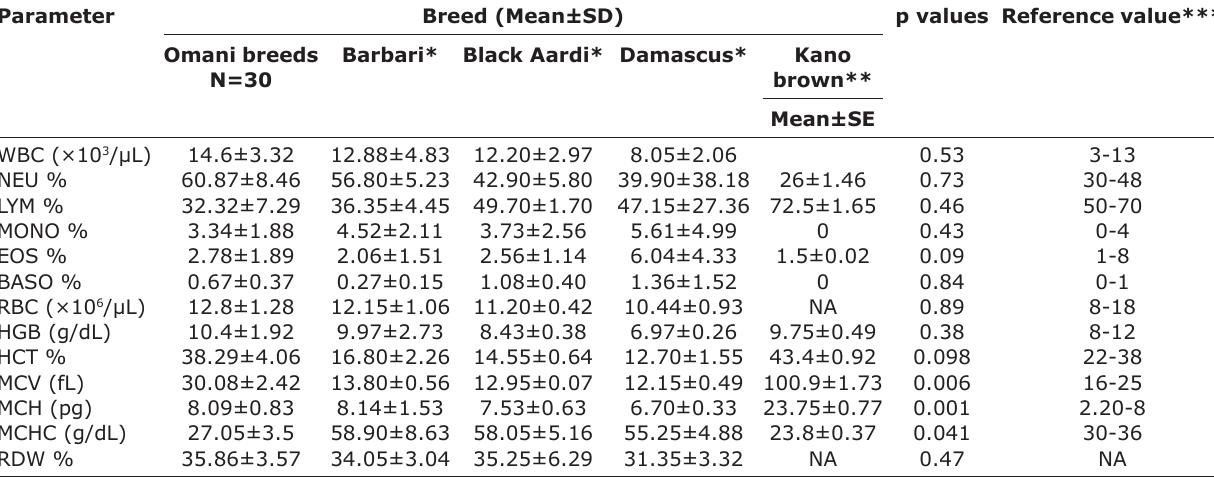
Table-1: Hematological values (mean±SD or SE) in Omani goat breeds and different breeds of goats. Parameter